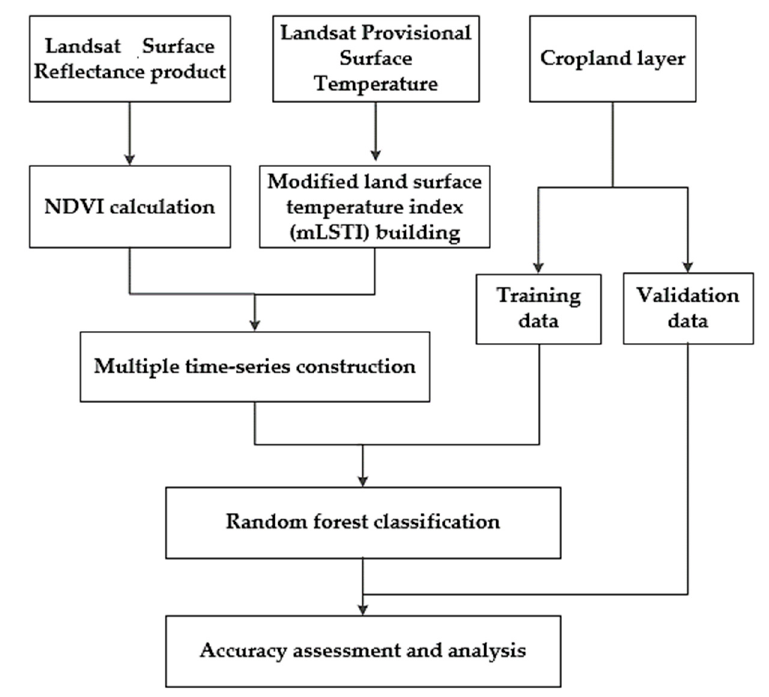
Figure 2. Flowchart of the research process.